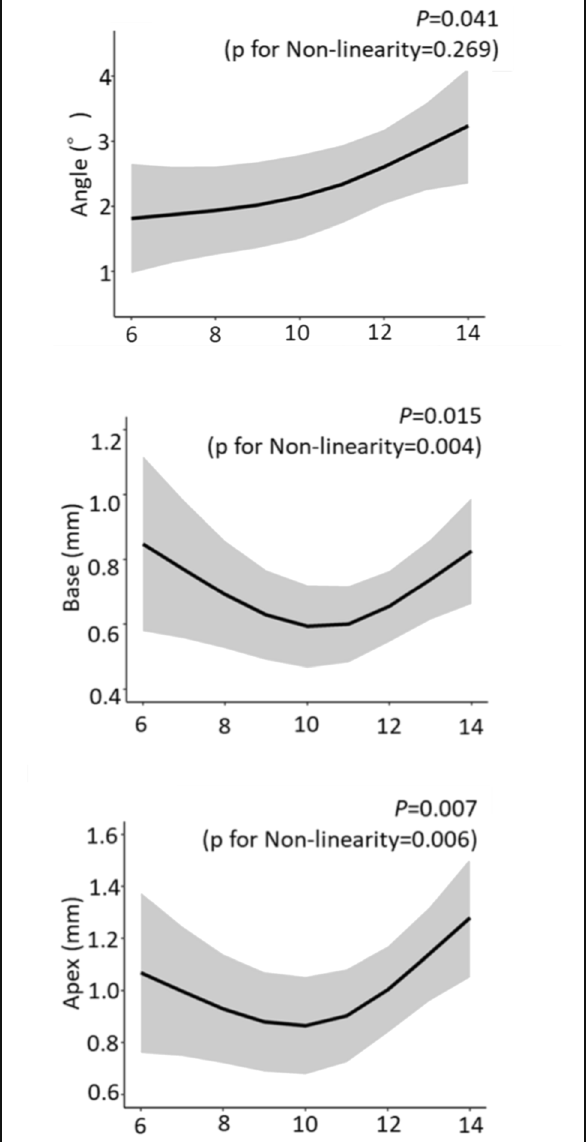
Fig. 13 The errors caused by differences in the number of teeth supporting the surgical guide. The shaded area shows 95% confidence